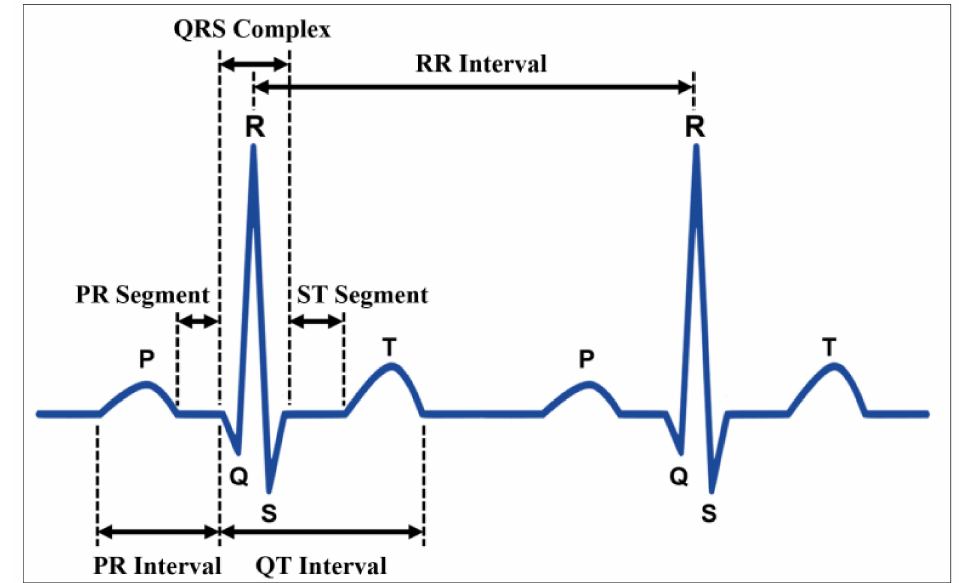
Figure 1. QRS Complex.